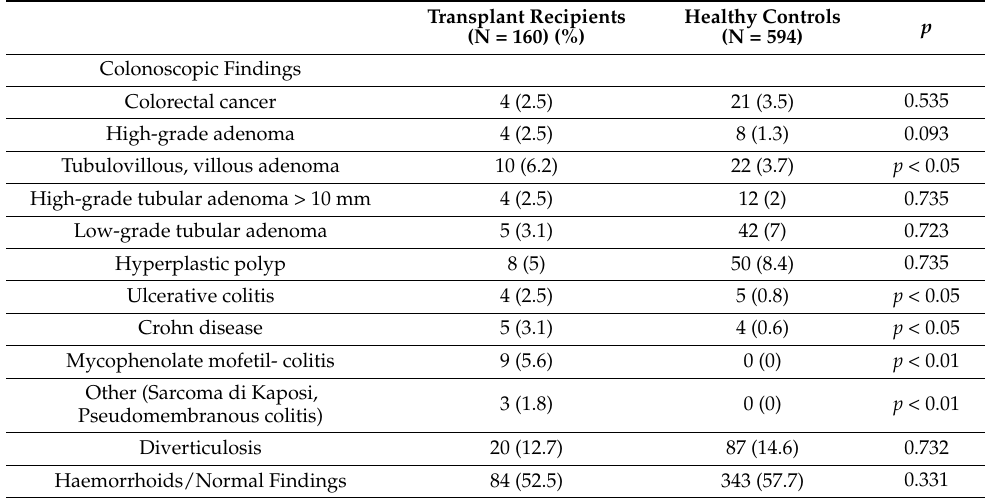
Table 2. The colonoscopic findings in kidney transplant recipients compared with the healthy